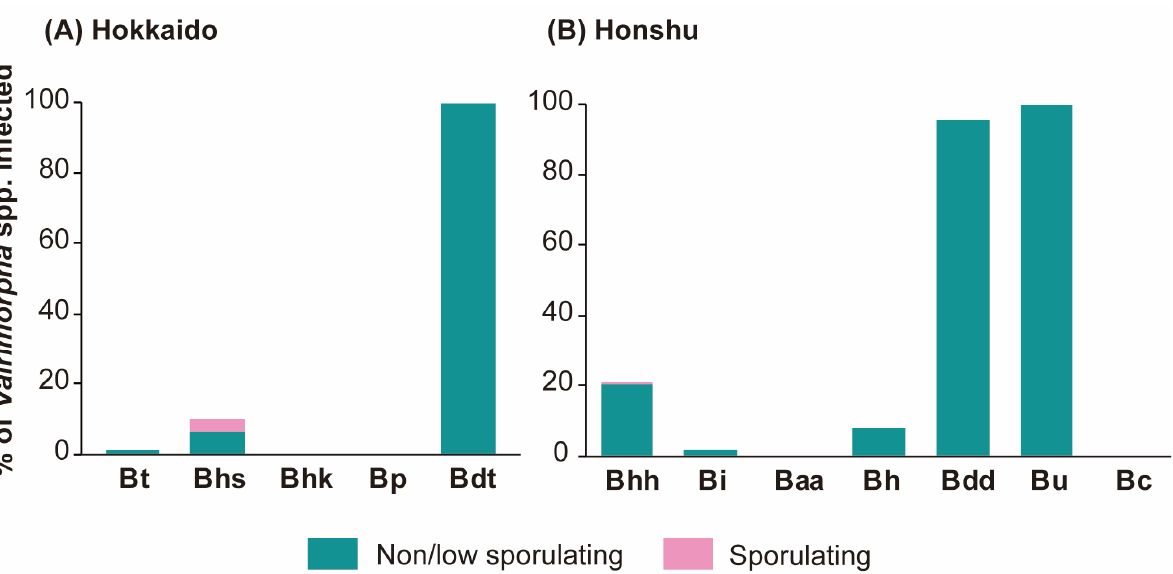
Figure 1. Prevalence of Vairimorpha spp. in different bumblebee species. Species names as abbrevia-